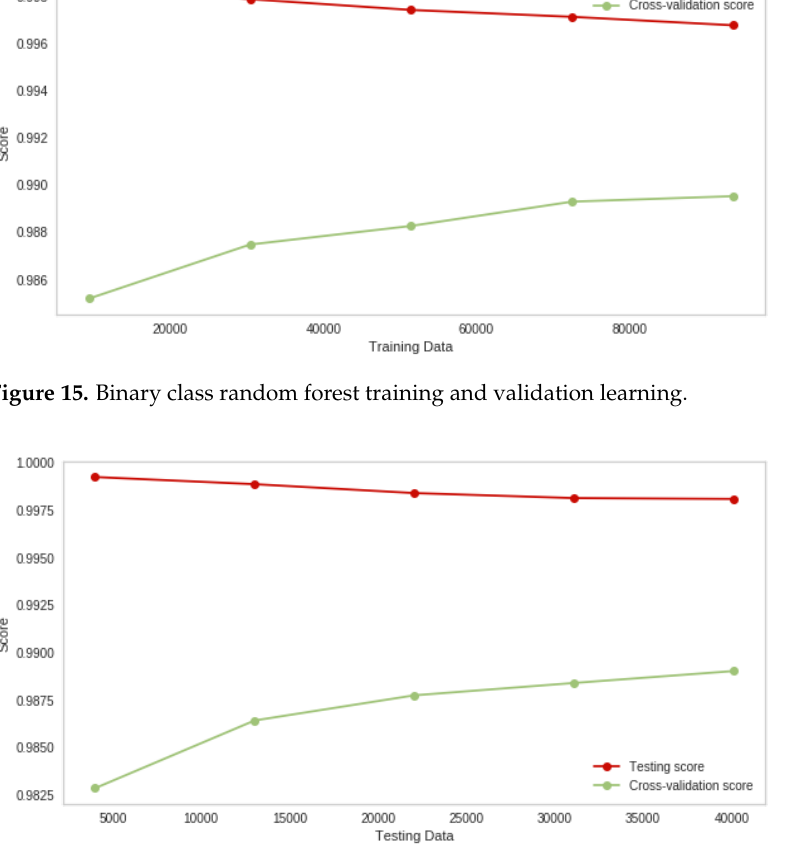
Figure 16. Binary class random forest testing and validation learning.